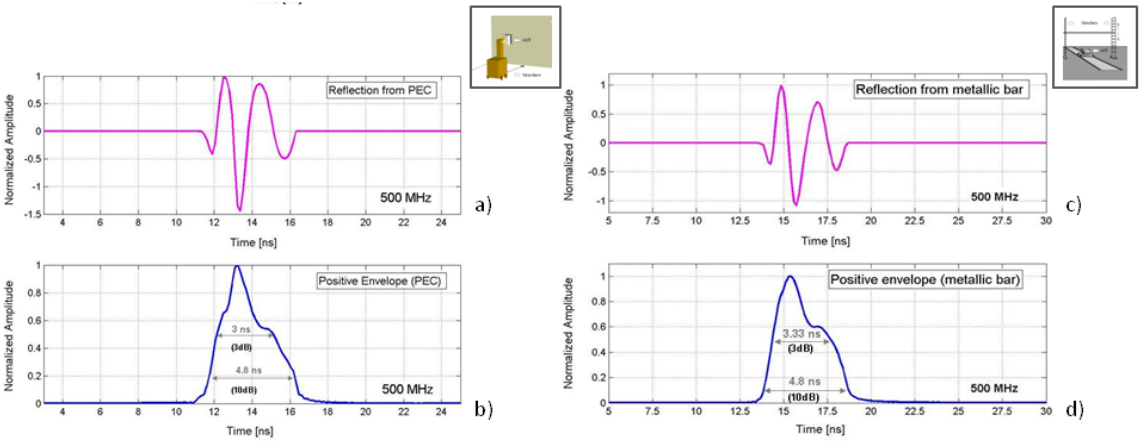
Figure 6. Reflected wavelet in air obtained for the AUT. (a-b) Recorded wavelet and positive envelope (PEC). (c-d) Recorded wavelet and positive envelope (metallic